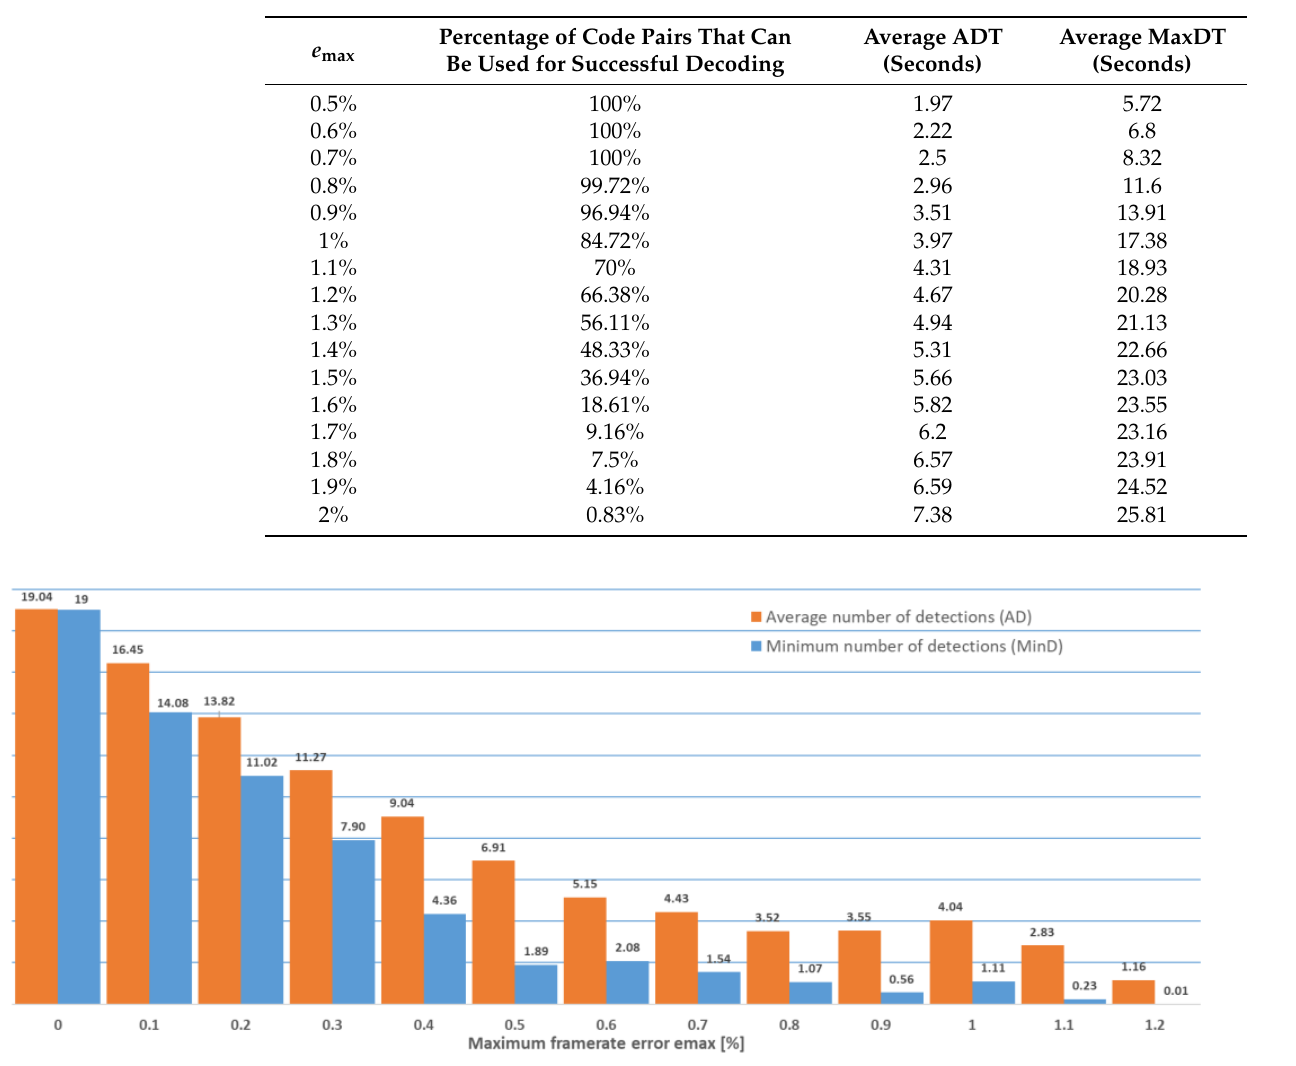
Table 2. Statistical analysis of the ADT and MaxDT (60 frames per second case).